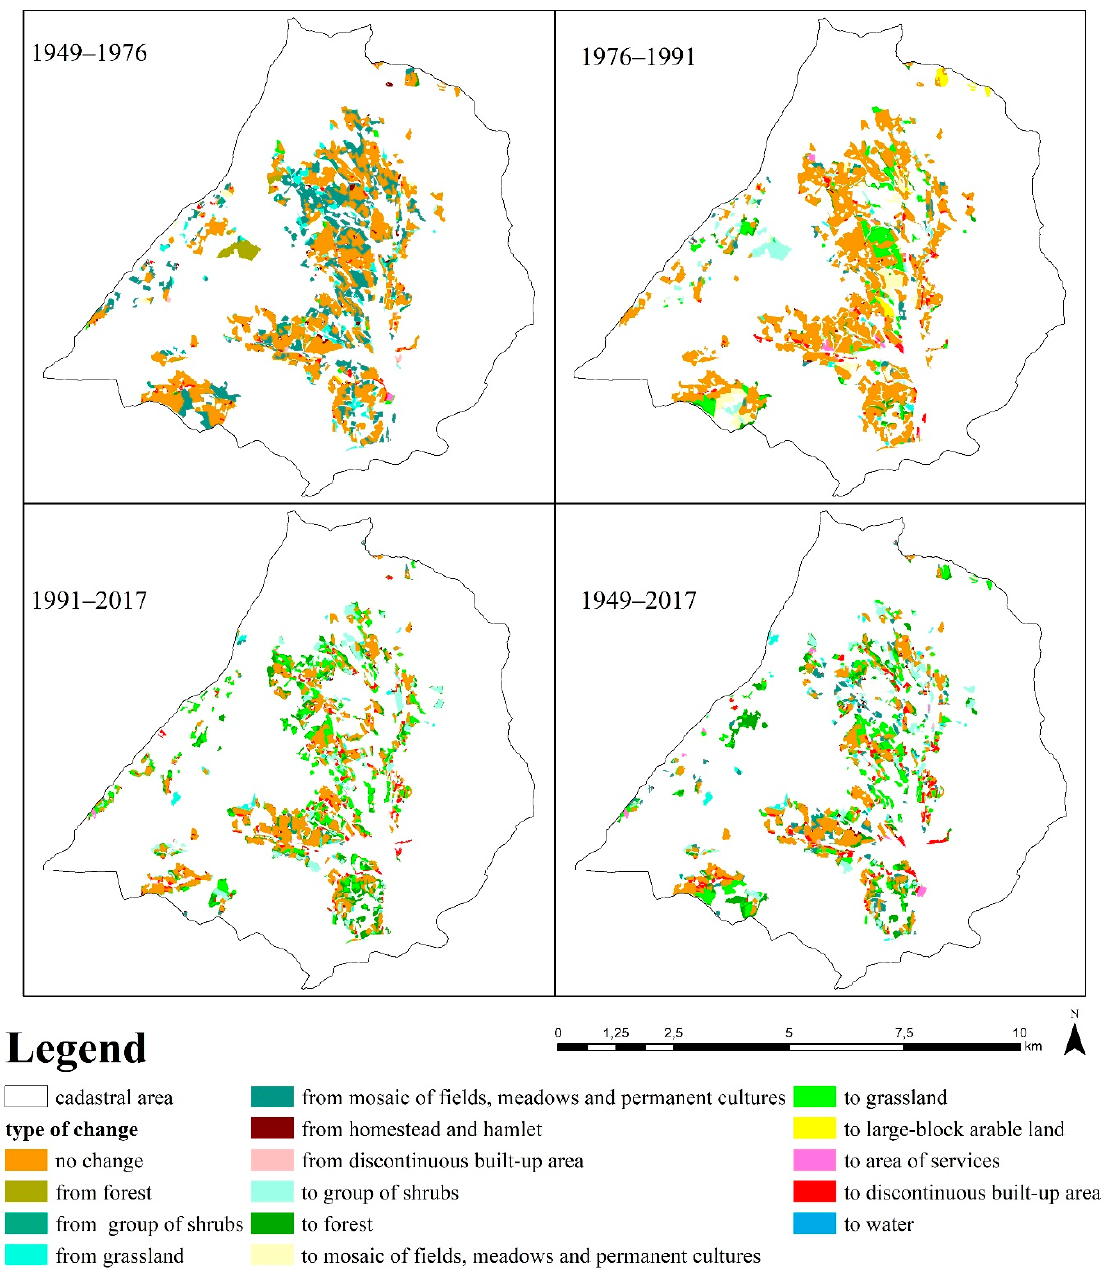
Figure 4. Land cover changes of traditional orchards in the cadastral area of Nová Ba ň a over the period 1949–2017.